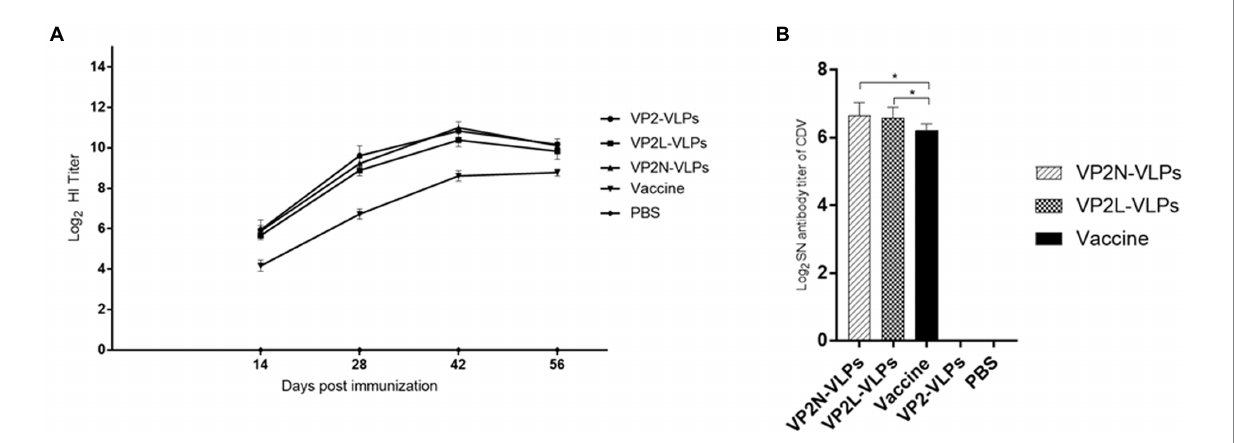
FIGURE 6 Determination of specific HI antibody titer against CPV at 14, 28, 42 and 56 dpi, and neutralizing antibody response to CDV via Vero-SLAM cells at 56 dpi after immunization with CPV VP2/VP2N/VP2L in mice. Each group of 6-week-old Balb/c mice ( n = 10) were immunized subcutaneously with 50 μ g of VP2, VP2L, VP2N recombinant protein, 100 μ l CPV/CDV live-attenuated vaccine and 100 μ l PBS at 0, 14, 28 dpi. (A) HI antibody titers of CPV in mice serum of each group at 14, 28, 42 and 56 dpi; (B) neutralizing antibody titers of CDV in mice of each group at 56 dpi. Data were analyzed using GraphPad 5.00. Asterisks indicate significant differences among the groups, as calculated by one-way ANOVA (* p < 0.05).